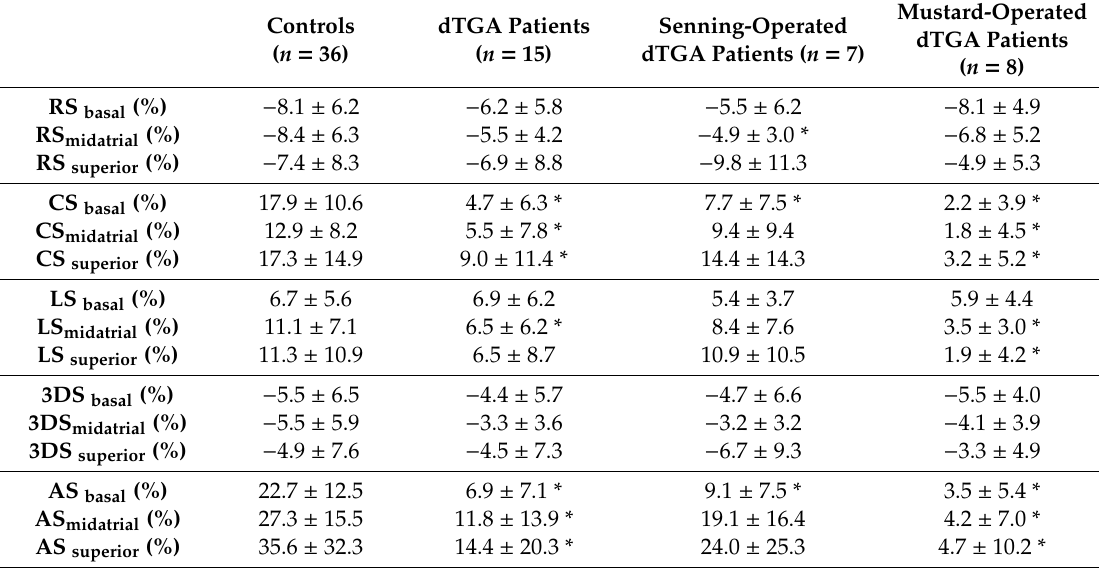
Table 6. Comparison of three-dimensional speckle-tracking echocardiography-derived regional left atrial strains at atrial contraction of patients with dextro-transposition of the great arteries and those of